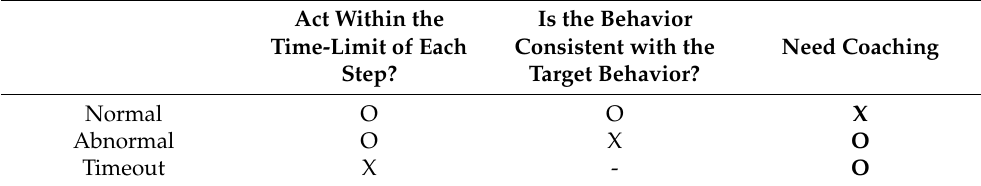
Table 1. Cases according to a user’s behavior at each step of the ADL scenario.